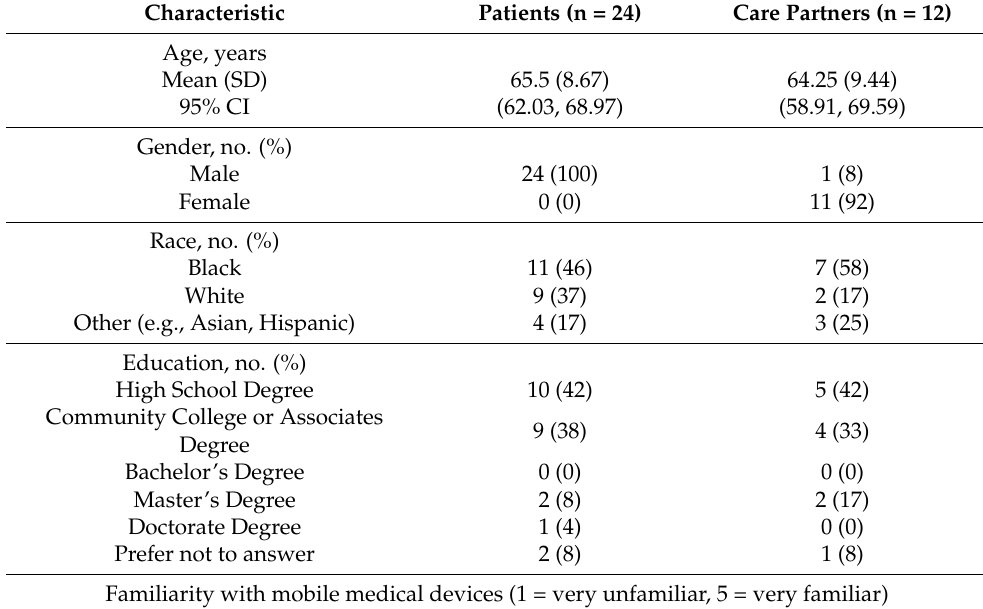
Table 1. Characteristics of the